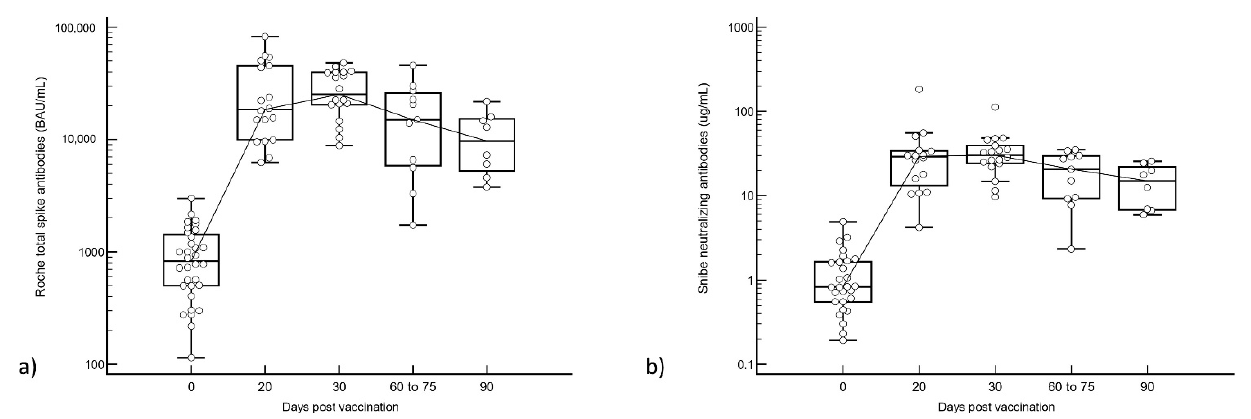
Figure 1. ( a ) Roche total spike and ( b ) Snibe neutralizing antibodies pre-booster and after booster vaccination. Antibodies are displayed on a semi-logarithmic scale.